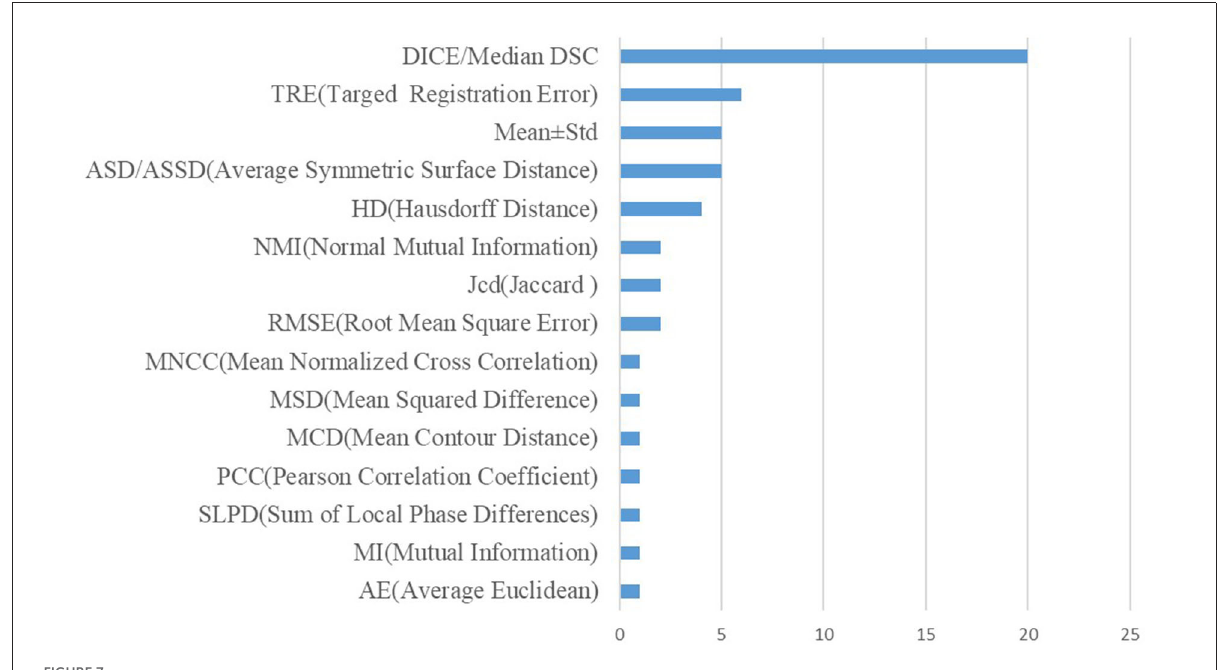
FIGURE7 Performance metrics statistics of existing registration